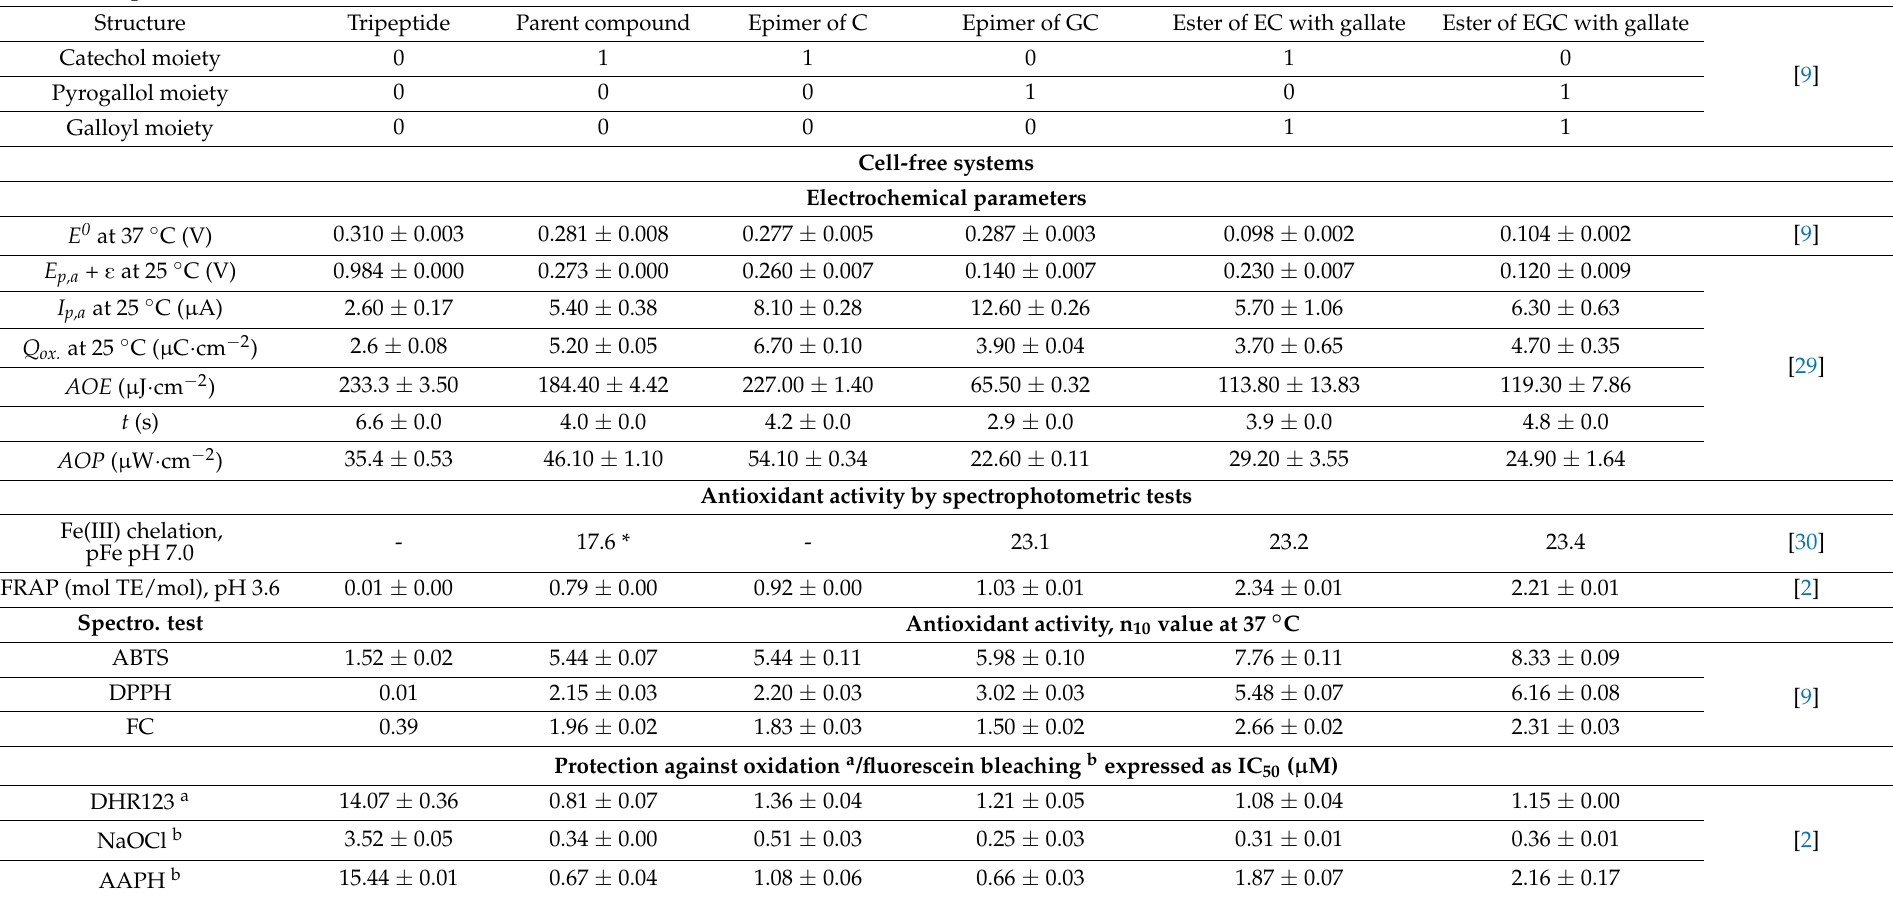
Table 1. Summary of data concerning chemical and electrochemical parameters as well as biological effects of